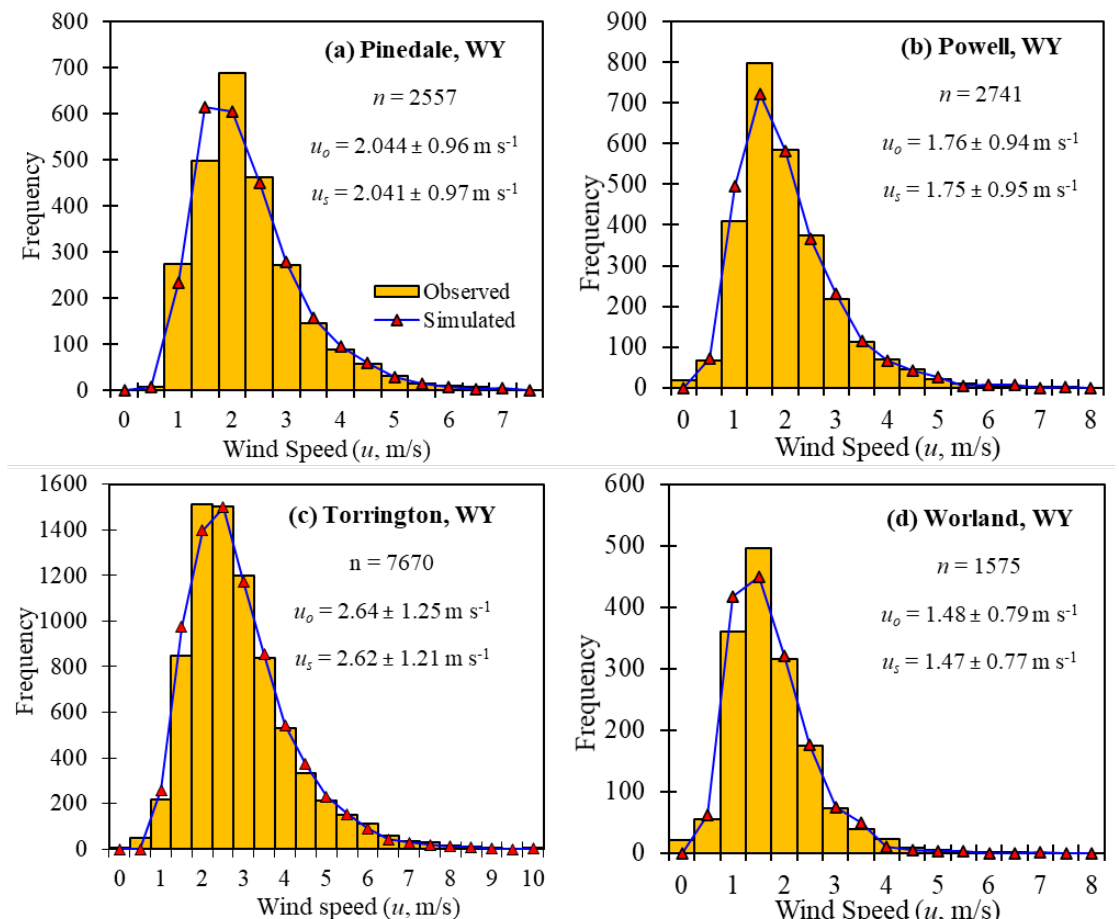
Figure 5. Histogram of daily wind speed ( u , m s − 1 ) from observed and simulated data for ( a ) Pinedale, ( b ) Powell, ( c ) Torrington, and ( d ) Worland, Wyoming. The u 0 and u s represent the mean and standard deviation for observed and simulated data.